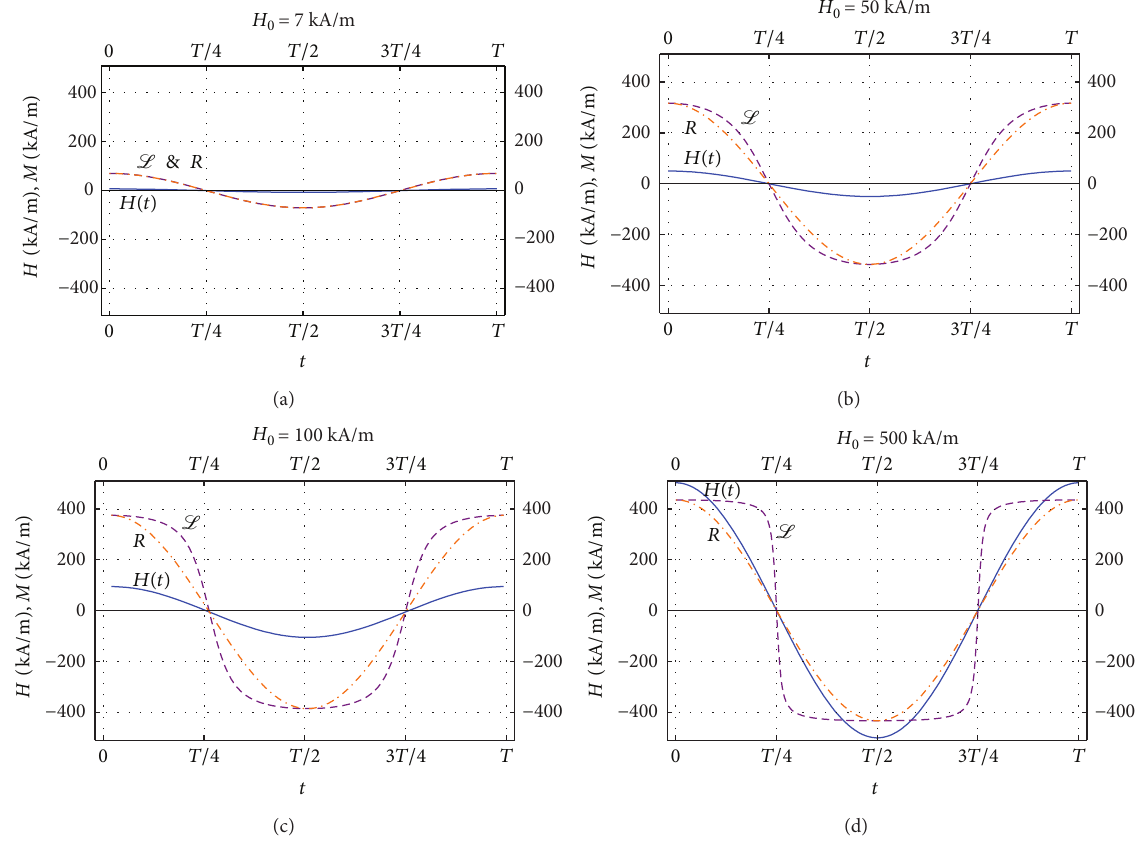
Figure 1: (colour online) The characteristic change of the equilibrium magnetization within a periodic driving cycle as given by the Langevin function( L ,equation(10))andRosensweig’schordsusceptibility( 𝑅 ,(12))fordifferent 𝐻 0 amplitudemagnetizingfield 𝐻(𝑡) = 𝐻 0 cos (2𝜋𝑡/𝑇) . At low 𝐻 0 field amplitudes the two curves are identical (a). At increasing 𝐻 0 field amplitudes only the extrema remain identical.